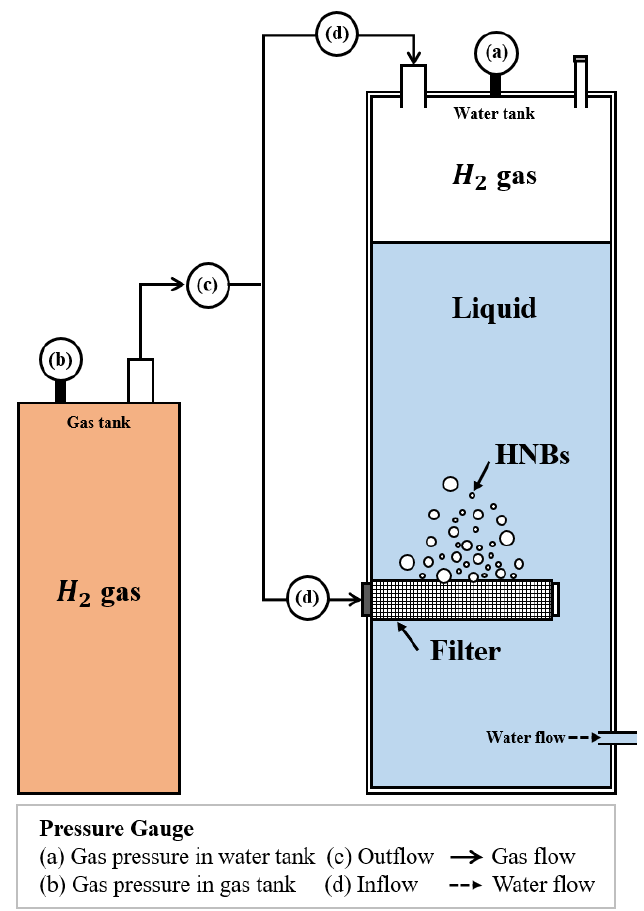
Figure 1. Schematic view of nanobubble generator.